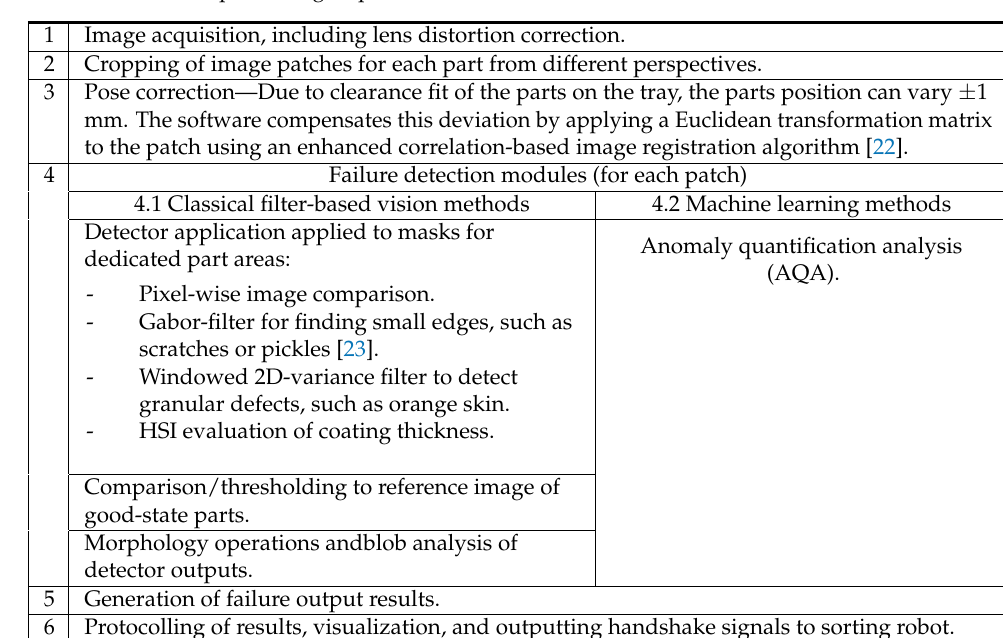
Table 1. Main data processing steps.